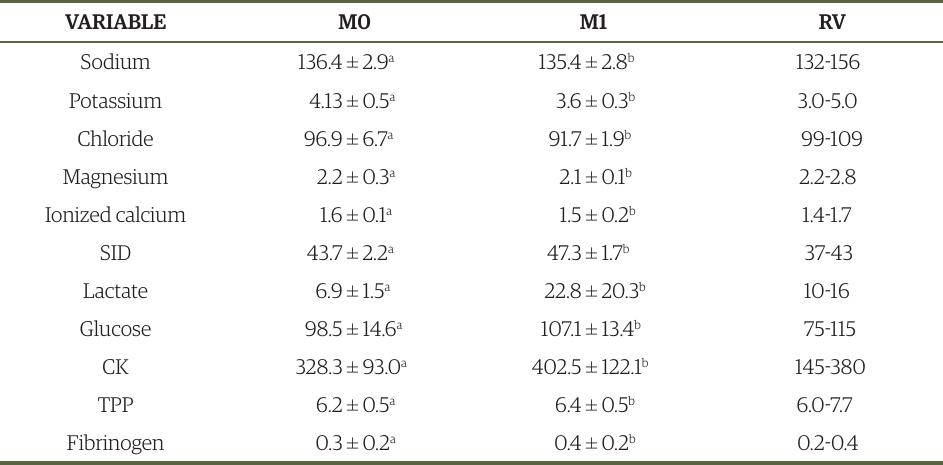
table 3. Mean and standard deviations of sodium (mEq L -1 ), potassium (mEq L -1 ), chloride (mEq L -1 ), magnesium (mg dL -1 ), ionized calcium (mmol L -1 ), SID (mmol L -1 ), lactate (mg dL -1 ), glucose (mg dL -1 ), creatine phosphokinase (U L -1 ), total plasma protein (g dL -1 ) and fibrinogen (g dL -1 ) before (M0) and after (M1) marcha exercise, followed by their respective reference values